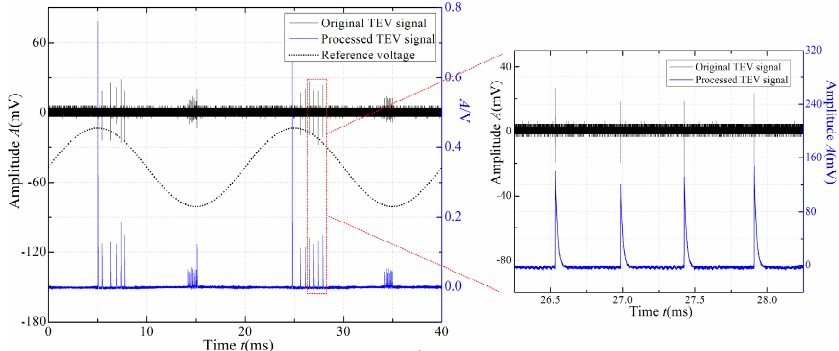
Figure 10. The original and processed TEV PD signals.